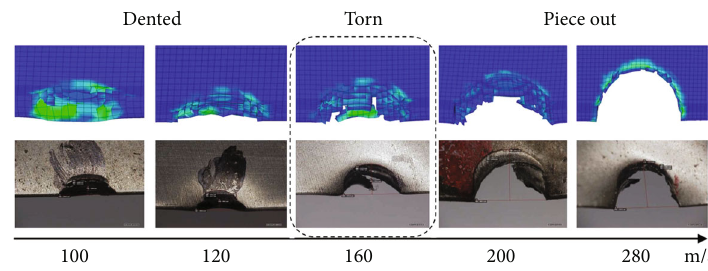
Figure 16: Comparison of experimental results with simulation results for 30 °